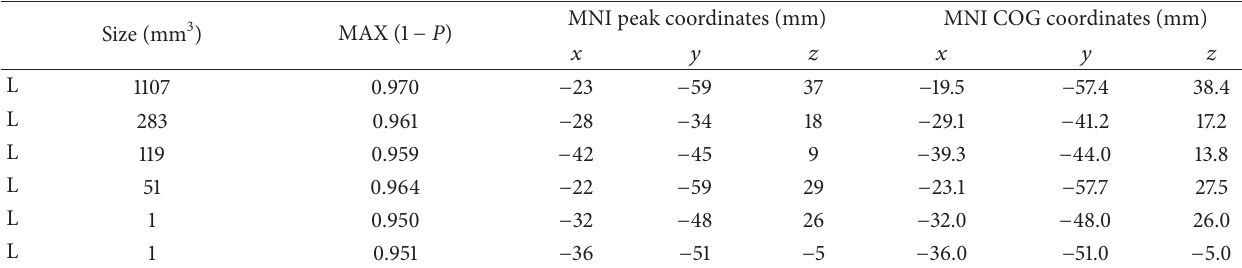
Table 6: White matter clusters in which tract-based spatial statistical analyses have shown significant increases in fractional anisotropy (FA) after training in Group